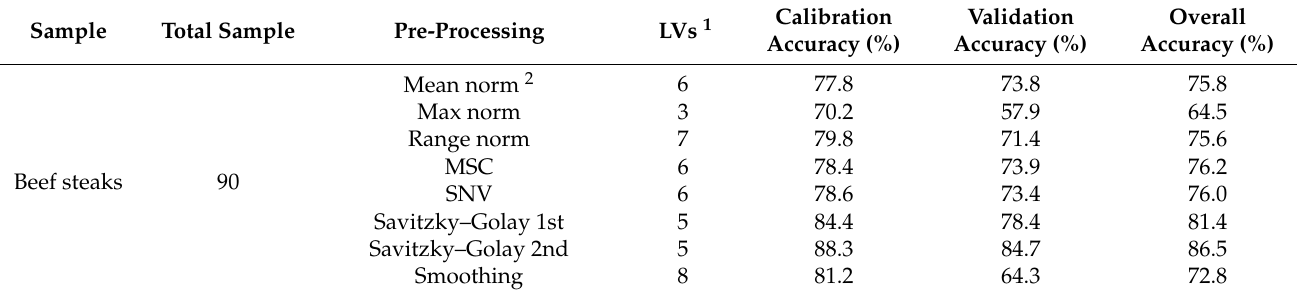
Table 1. PLS-DA model classification results applying different pre-processing methods. Sample Total Sample